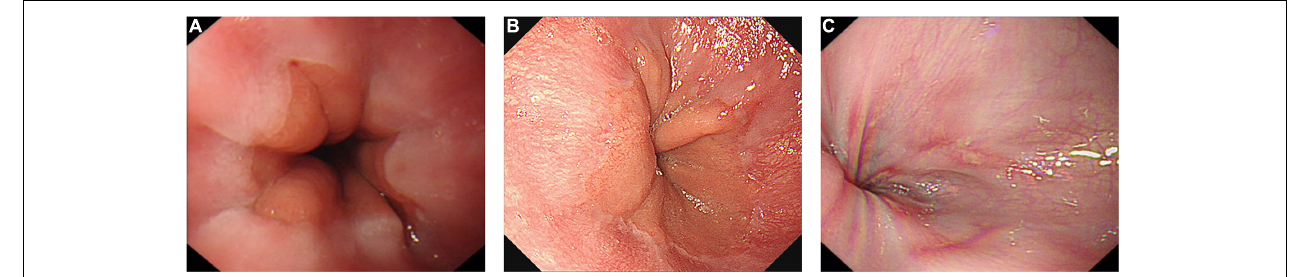
FIGURE 3 | Postoperative endoscopy with a minimum follow-up of 5 years. (A) No abnormality. (B) Reflux esophagitis (Los Angeles Type A). (C) Reflux esophagitis (Los Angeles Type B).